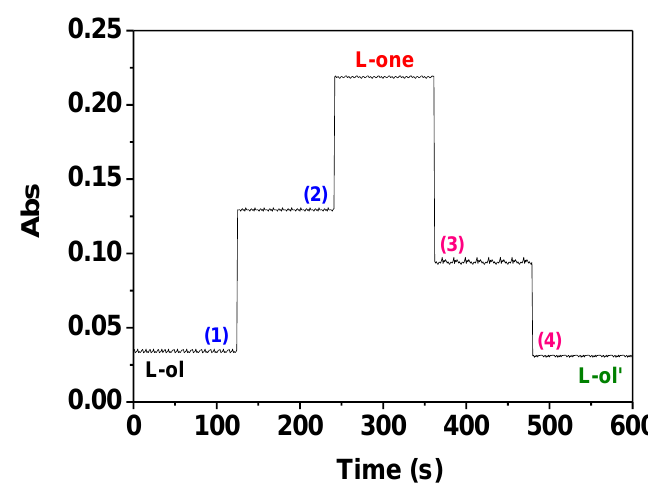
Figure 7. Time course UV-vis absorption response of L-ol (10 μM) to (1) 20 μM, (2) 50 μM HOCl, and in-situ formed L-one to (3) 100 μM (4) 500 μM GSH in PBS aqueous buffer (DMSO: H 2 O =9:1, 20 mM, pH=7.4).